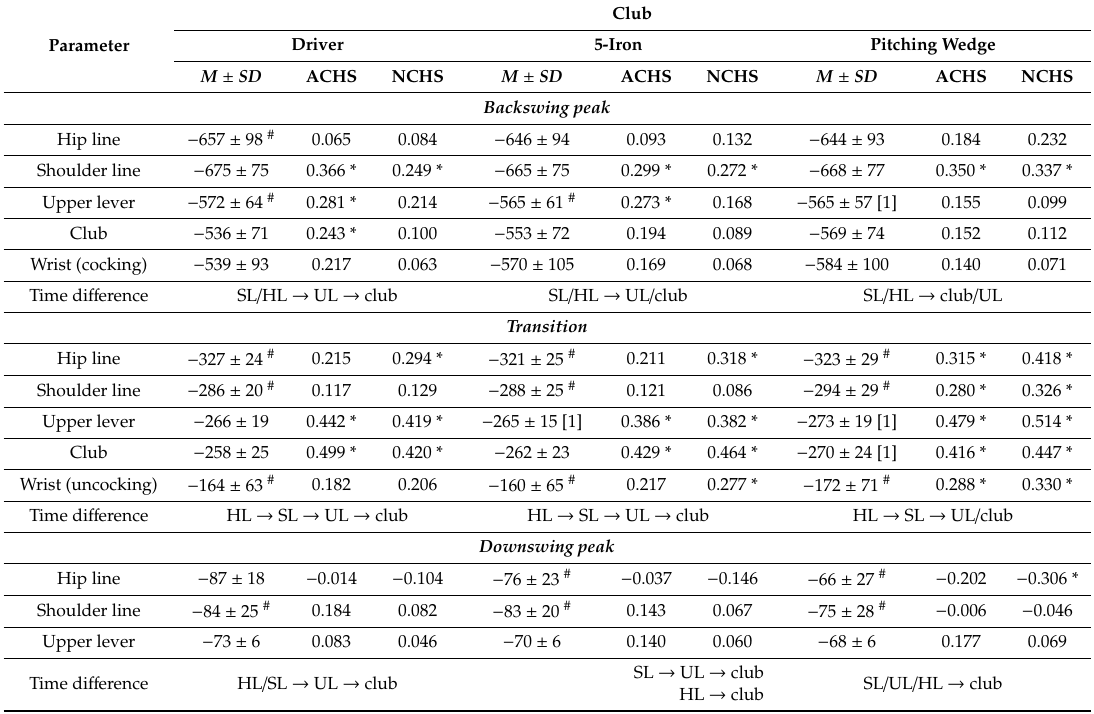
Table 3. Correlation coe ffi cients of the kinematic-sequence time parameters (in ms; relative to BI) to clubhead speed ( n =